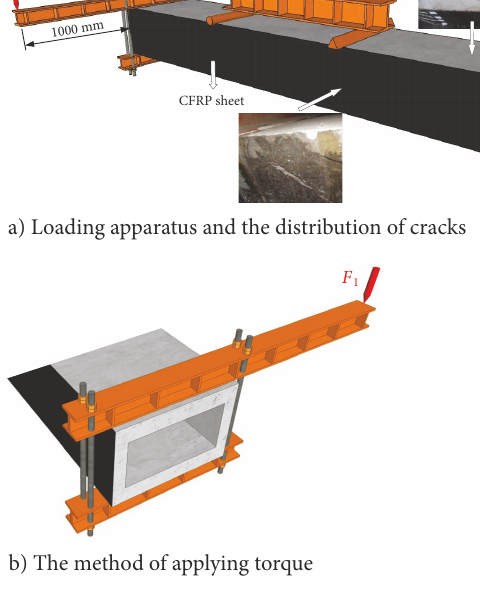
Figure 3. The simplified model of experimental RC box-girder and loading mode: a – loading apparatus and the distribution of cracks; b – the method of applying torque